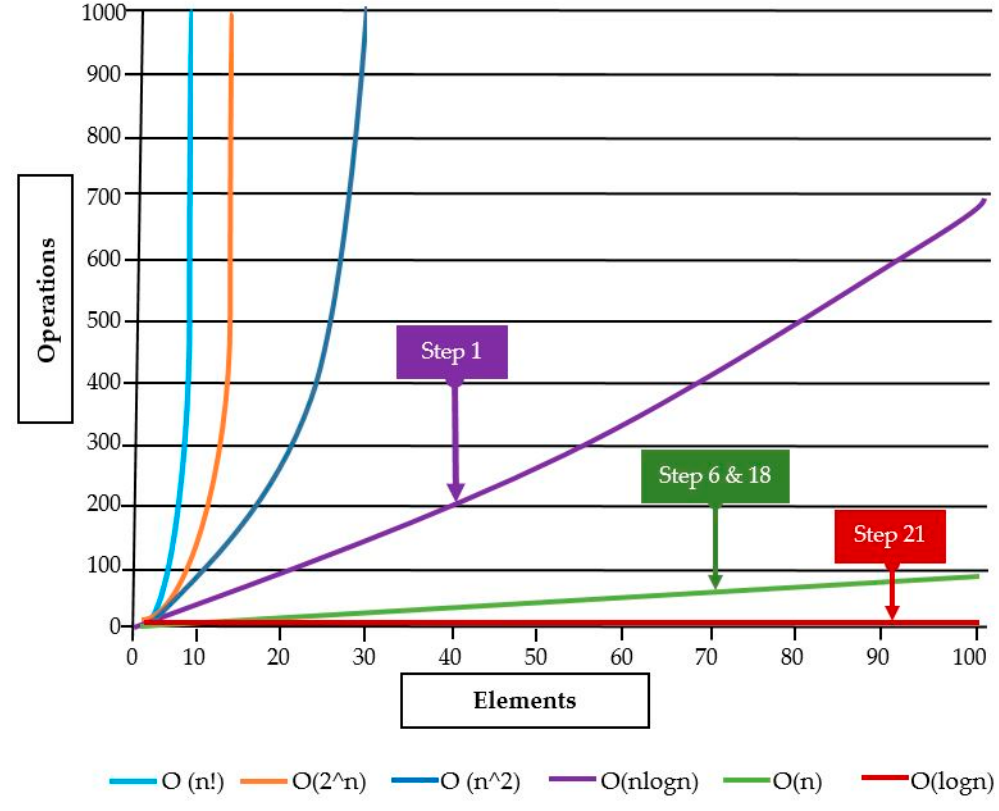
Figure 3. Big-O Complexity and result classification.